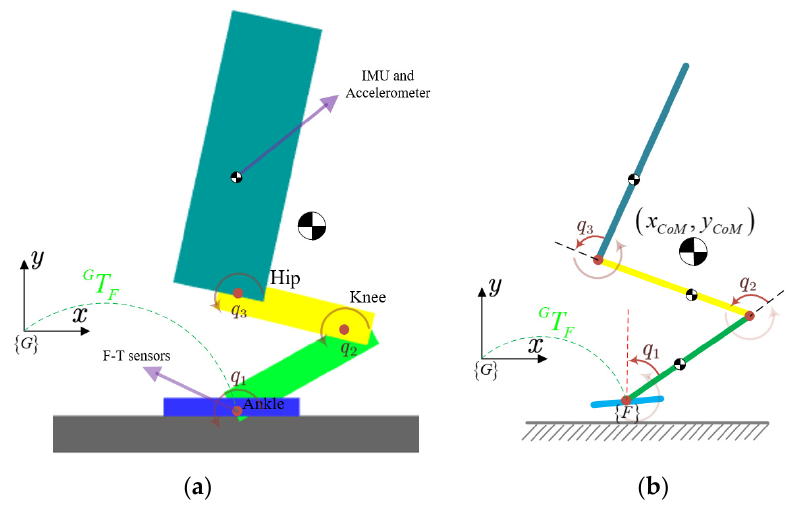
Figure 2. Jumping models for the planar biped robot in simulations and its generalized coordinates. ( a ) Jumping models in simulation. ( b ) Simplified configuration of the mechanical structure. { G } is attached to the ground. The robot’s foot frame is denoted { F } , and homogeneous transformation matrix G T converts coordinates from { G } to { F } .